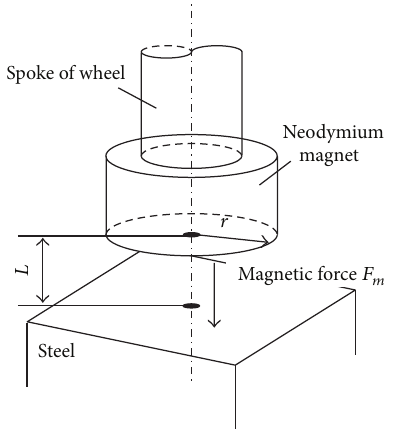
Figure 4: Magnetic force between spoke and steel surface.